Question: What form of chart is displayed?
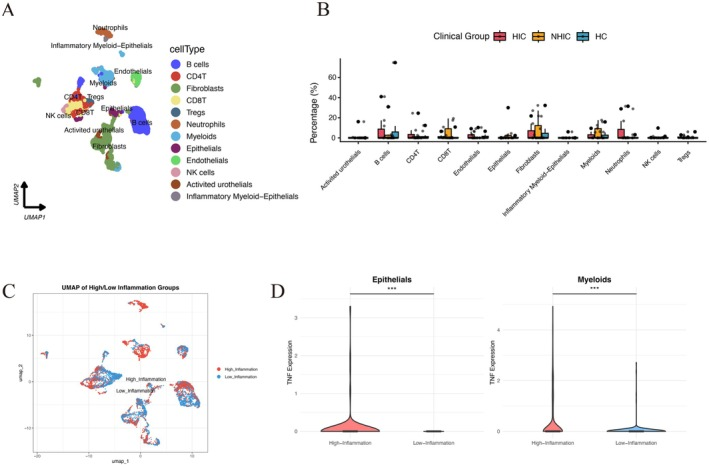
Answer: scatter